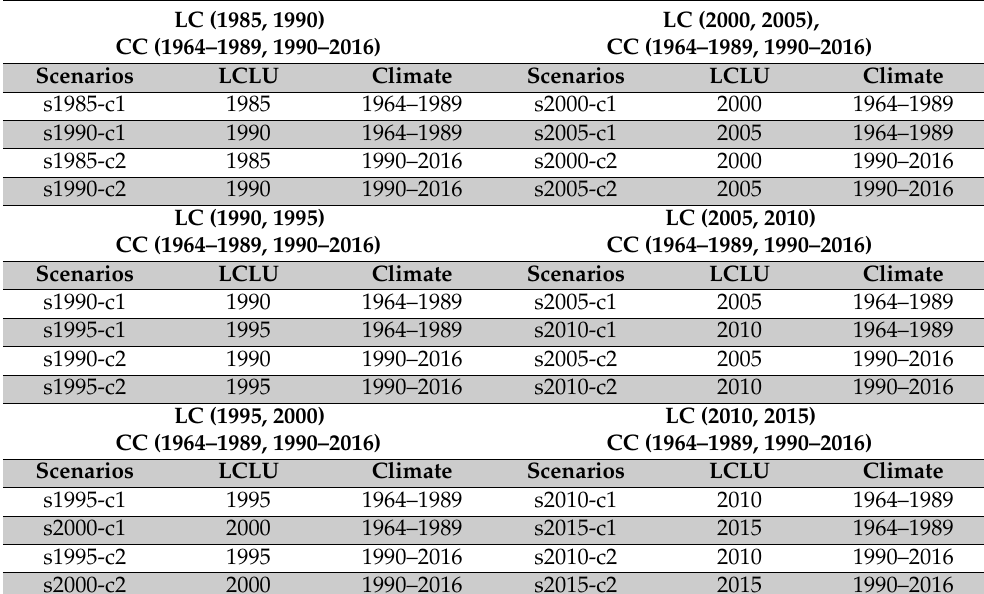
Figure 3. Schematic diagram for the quantification of impacts of climate change ( a ) and land-cover change ( b ) streamflow. C 1 , C 2 , L 1 , and L 2 are climate and land cover, while 1 and 2 are different periods. ΔC and ΔL are climate change, and land- cover change in two periods. The hydrological components (i.e., streamflow or evapotranspiration) value at point A, B, C, and D are Q L1 and Q L1 , respectively, modified from [74]. C2 Table 1. Hypothetical scenarios for attribution of streamflow changes to climate change and land- cover change.